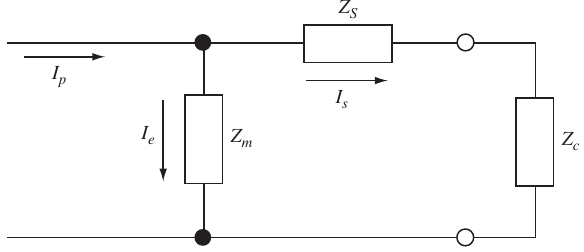
Figure 1. Equivalent electric circuit of a current transformer.